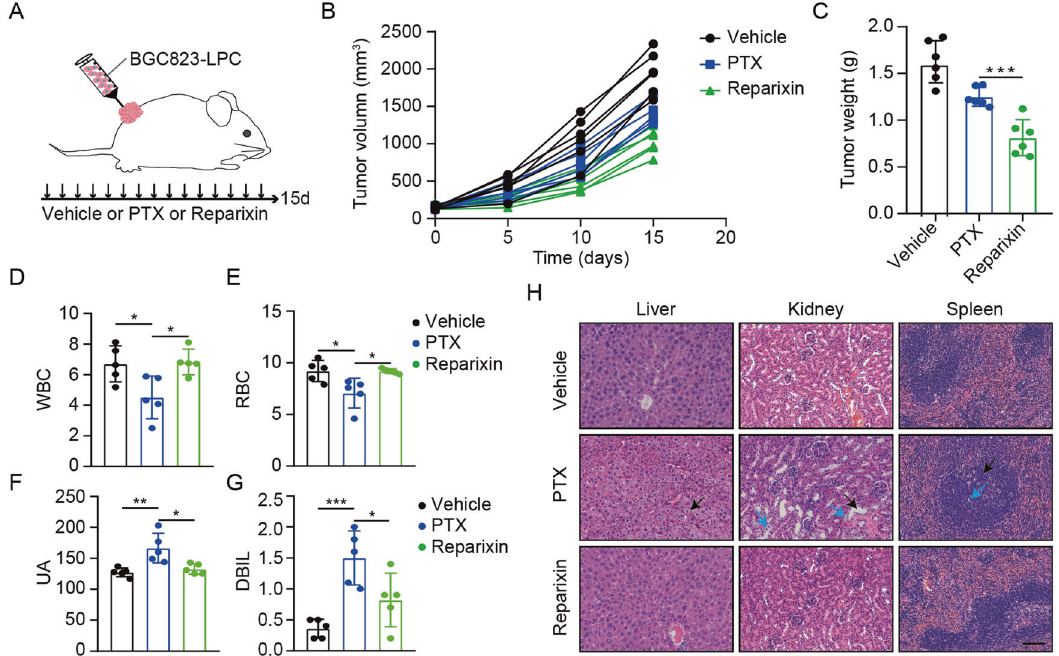
Fig. 5 Sequential treatment with fi rst-line, second-line chemotherapy, and reparixin inhibits GC growth in vivo. A Schematic representation of the BGC823-LPC cells from tumor tissues subjected to fi rst-line and second-line chemotherapy xenograft model for reparixin treatment. B The growth curves of tumor ( n = 6 per group). C The tumor weights were measured and recorded after the tumors were harvested. Data are mean ± standard deviation. *** P < 0.001. D , E Blood routine index (WBC and RBC) were measured. Data are mean ± standard deviation. * P < 0.05. F , G Blood biochemical index (DBIL and UA) were measured. Data are mean ± standard deviation. * P < 0.05. H The representative images of liver, kidney, and spleen by H&E staining. Scale bars, 50 μ